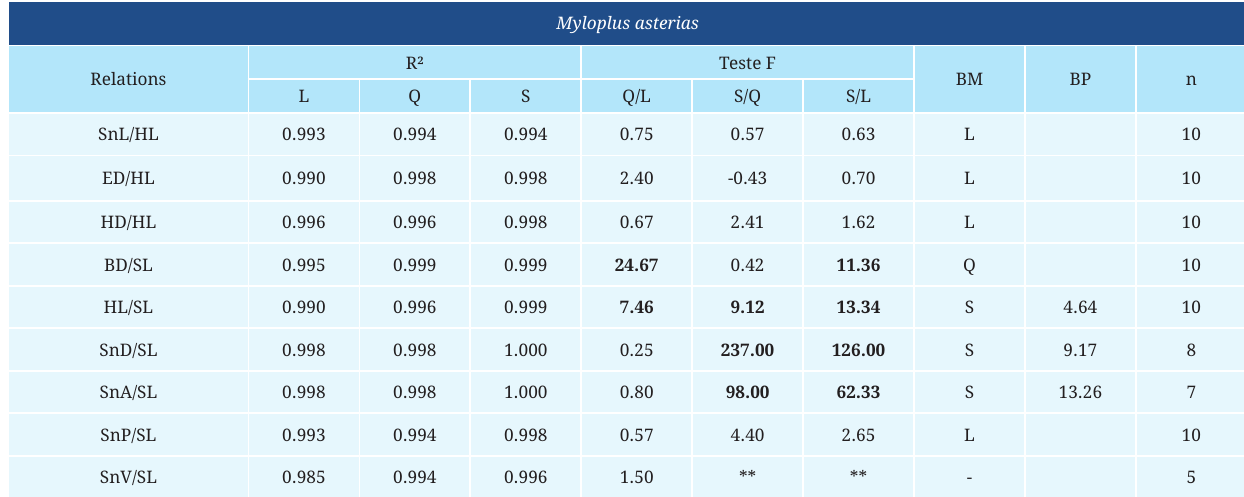
TABLE 2 | Values of linear (L), quadratic (Q) and piecewise (S) regression analyses of morphometric variables in relation to head length (HL) and standard length (SL) of larvae and juveniles of Myloplus asterias . R² = coefficient of determination. BM = best model, BP = breaking